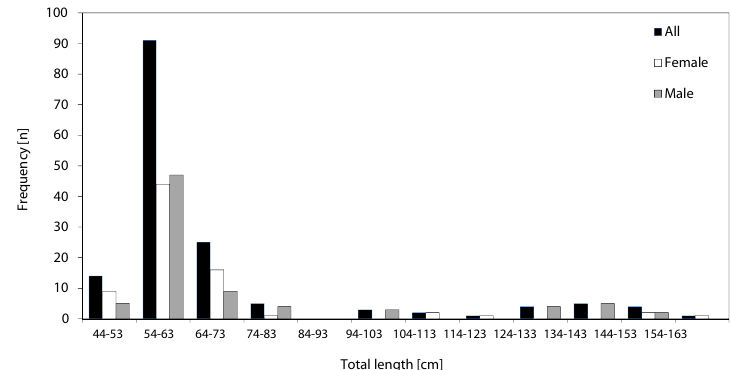
Fig. 3. Total length frequency analysis of Mustelus mustelus from the Gulf of Iskenderun, north-eastern Mediterranean